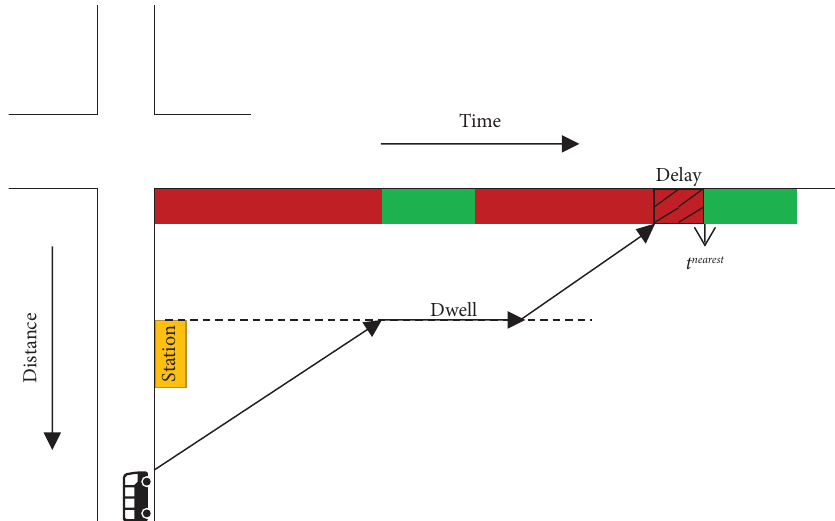
Figure 3: Diagram of the delay estimation of